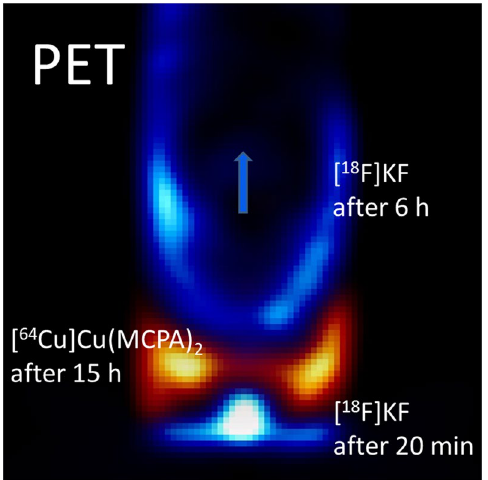
Figure 2. The snapshot shows an overlay of tracer propagation of both the conservative [ 18 F]KF tracer experiment #2 (blue colors) and the reactive [ 64 Cu]Cu(MCPA) 2 tracer experiment #3 (orange colors) at different times. Comparison of the two frames of experiment #2 (20 min and 6 h after injection of the tracer pulse) with one frame of experiment #3 (15 h after injection of the tracer pulse) shows substantial retardation of the reactive tracer [ 64 Cu]Cu(MCPA) 2 . Frame height is 85 mm, frame width is 40 mm, voxel size is 1.15 mm. A smoothing of the image data was applied to increase the signal-to-noise ratio, but causes reduction of the spatial resolution to 2–3